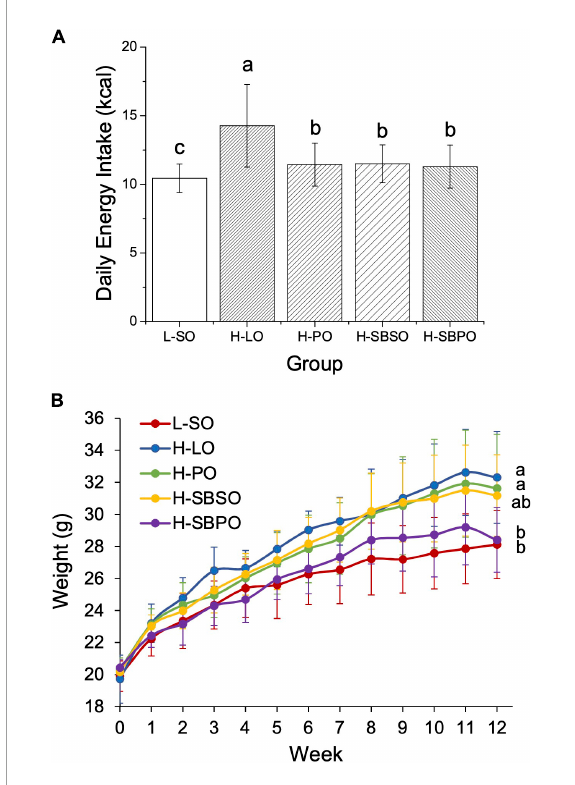
FIGURE1 (A) Daily energy intake, (B) body weight change over a 12-week treatment period fed with one of the five diets ( n = 12).